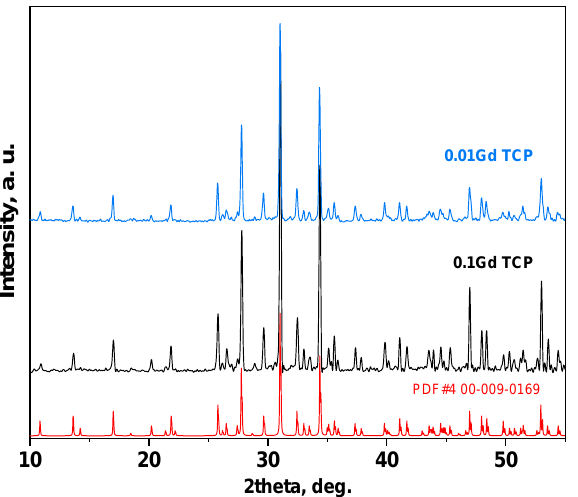
Figure 1. XRD patterns of Gd-TCP powders obtained by precipitation and mechanochemical activation: 0.01-Gd-TCP (blue), 0.1-Gd-TCP (black), and their comparison with the JCPDS PDF-4 card for the β -TCP (red).